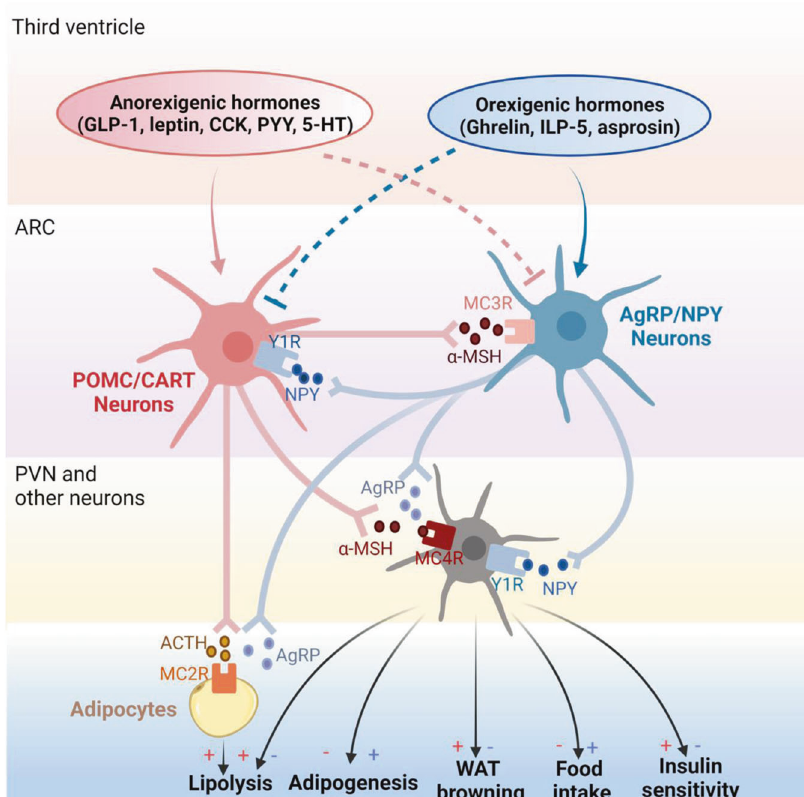
Fig. 6 Melanocortin pathway in obesity pathogenesis. The melanocortin pathway consists of POMC; melanocortin receptors MC1R-MC5R; and agouti and AgRP. POMC/CART neurons in ARC are stimulated by anorexigenic hormones in the third ventricle like GLP-1, leptin, CCK, PYY, and 5-HT, while suppressed by orexigenic hormones like Ghrelin, ILP-5, and asprosin. Upon stimulation, POMC/CART neurons secrete POMC including α -MSH and ACTH. α -MSH is released into the PVN. By interacting with MC4R, α -MSH activates PVN neurons and displays anti-obesity effects by inhibiting adipogenesis, promoting lipolysis, inducing WAT browning, reducing food intake, and improving insulin sensitivity. ACTH released by POMC/CART neurons actions on adipocytes directly by binding to MC2R, further promoting lipolysis. However, these effects can be abolished by AgRP, which is the endogenous antagonist of POMC and is secreted by AgRP/NPY neurons in ARC. Conversely, AgRP/NPY neurons can be stimulated by orexigenic hormones in the third ventricle but inhibited by anorexigenic hormones. Notably, POMC/CART and AgRP/NPY neurons interact mutually. NPY receptor Y1R is expressed in POMC/CART neurons and its activation inhibits POMC neurons in the ARC. In contrast, MC3R expressed in AgRP/NPY neurons seems to increase food intake in an “ AgRP circuitry ” -dependent